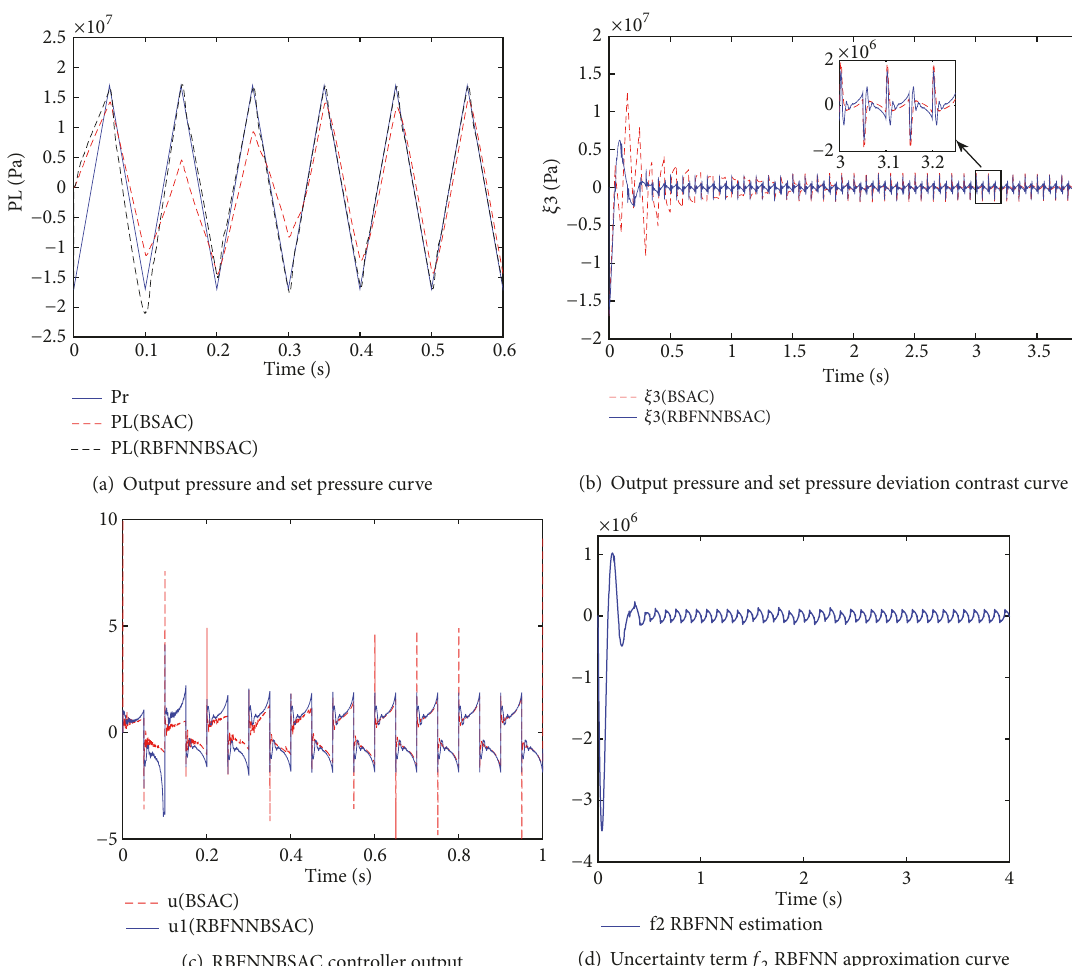
Figure 7: Performance curve of dynamic pressure cylinder AMESim model RBF neural network backstepping sliding mode adaptive control (10Hz triangle